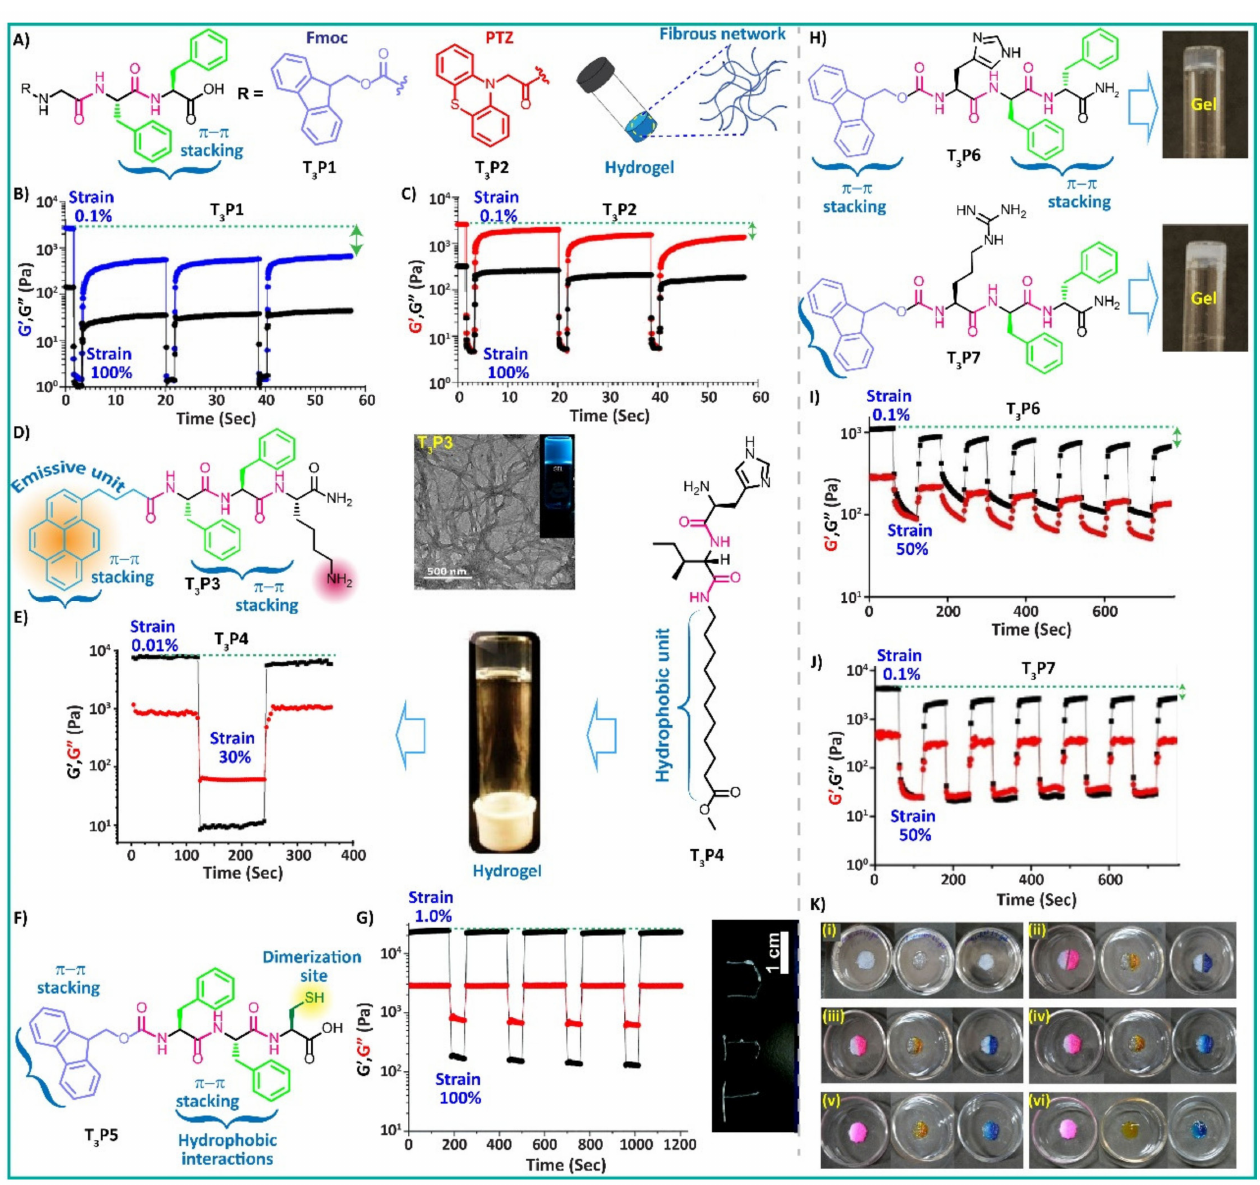
Figure 9. ( A ) Chemical structure and self-assembly of the tripeptide hydrogelators (T 3 P1 and T 3 P2). ( B , C ) Thixotropic step-strain experiment of the tripeptide gelators; reproduced with